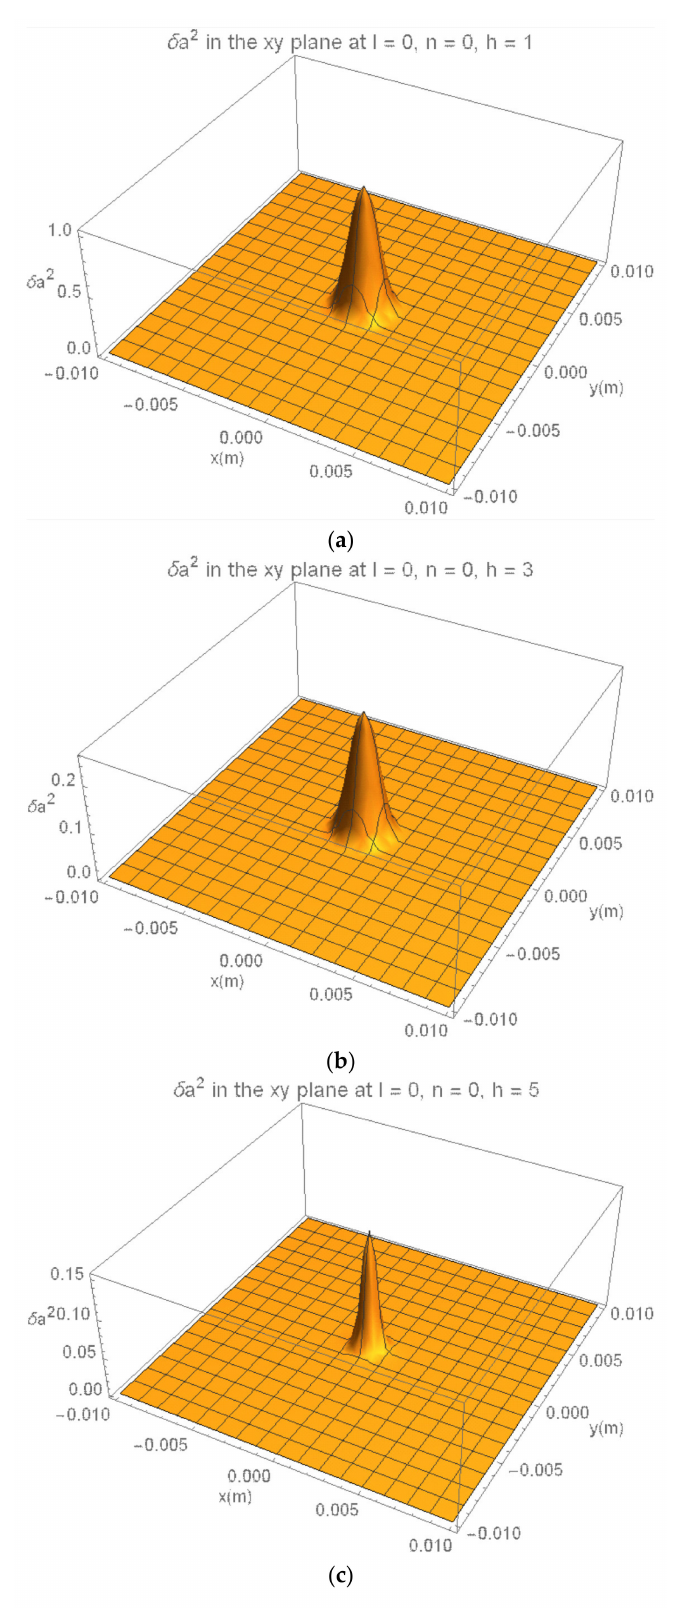
Figure 4. Evolutions of the field intensity of polarized radiation for the fundamental and higher-order modes of l = 0, n = 0, h = 1 ( a ), h = 3 ( b ), and h = 5 ( c ) in the two-beam system with an emittance of ε n = 0.1 mm · mrad and an energy spread of 0.1% (color